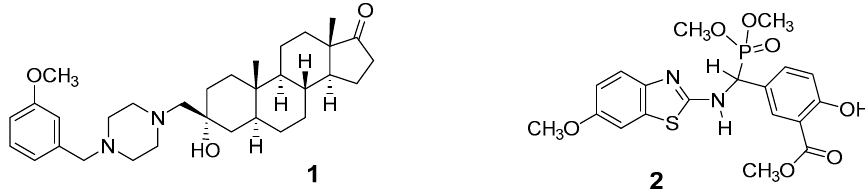
Figure 1. Steroidal and nonsteroidal compounds 1 and 2 , respectively, representative of two families of 17 β -hydroxysteroid dehydrogenase type 10 (17 β -HSD10) inhibitors.